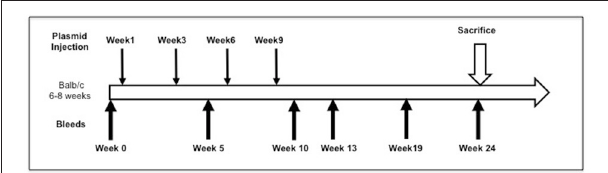
FIGURE 1 | Immunization scheme of the mouse model. Female Balb/c mice of 6–8 weeks were used in this study. Test animals ( n = 20) were injected with expression plasmids pEGFP-hTSHR and control animals ( n = 10) with pEGFP-N1 empty vector, respectively with 50 µ l of plasmid DNA in the bicep femoris muscle and electroporated as described in materials and method. This immunization scheme was done every 3 weeks for a total of 4 times. The mice were bled at 0, 5, 10, 13, 19, and 24